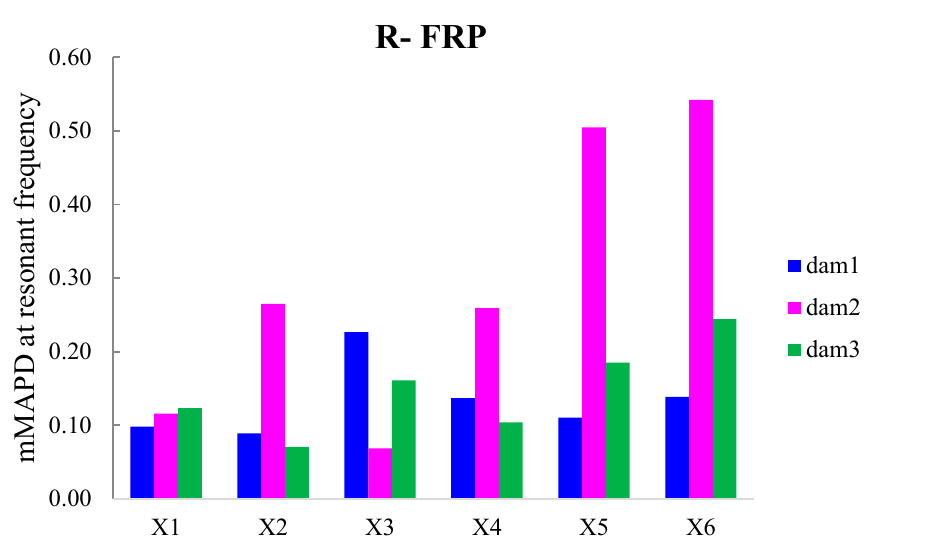
Figure 20. mMAPD at the resonant frequency of PTZs externally bonded on the surface of F-FRP.